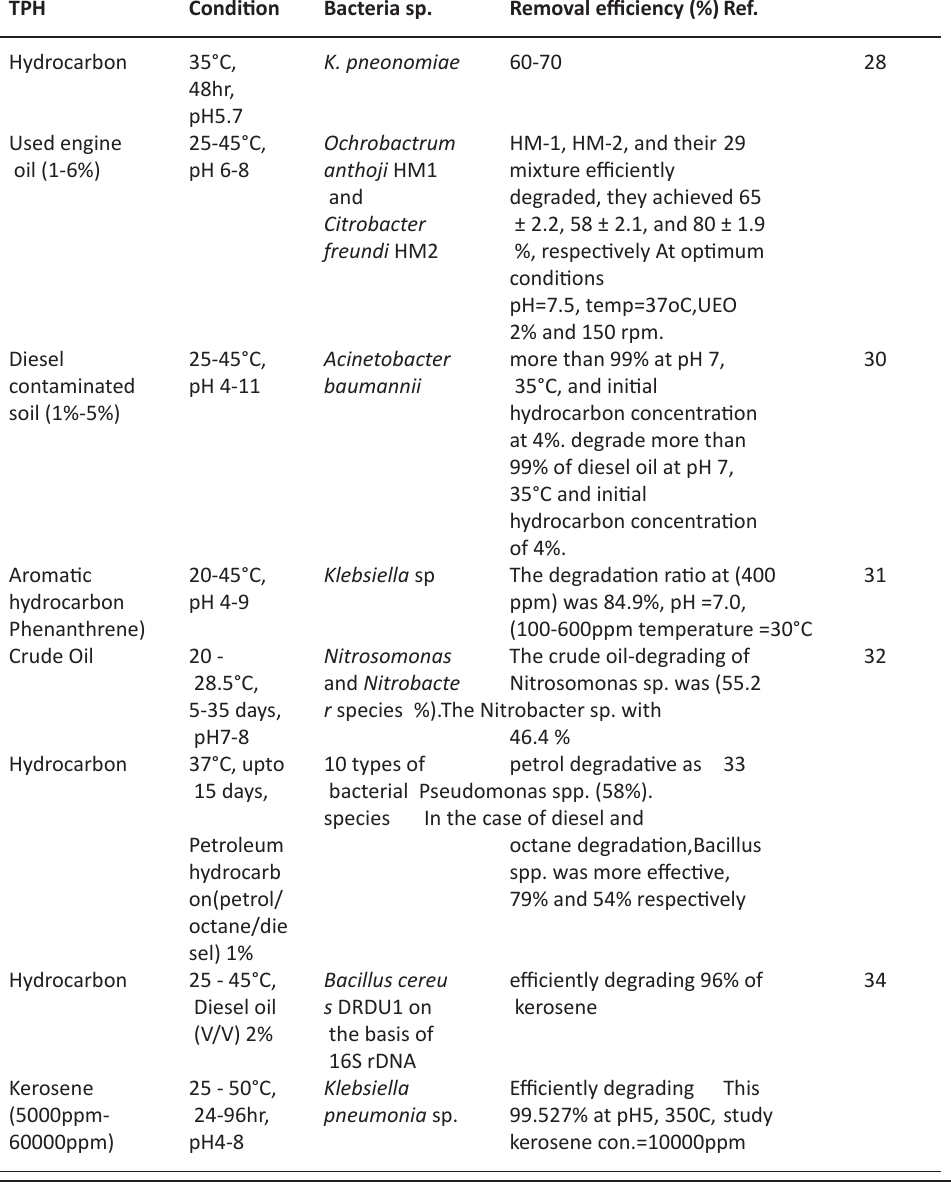
Table 2. Previous studies for bioremediation of hydrocarbon by bacteria